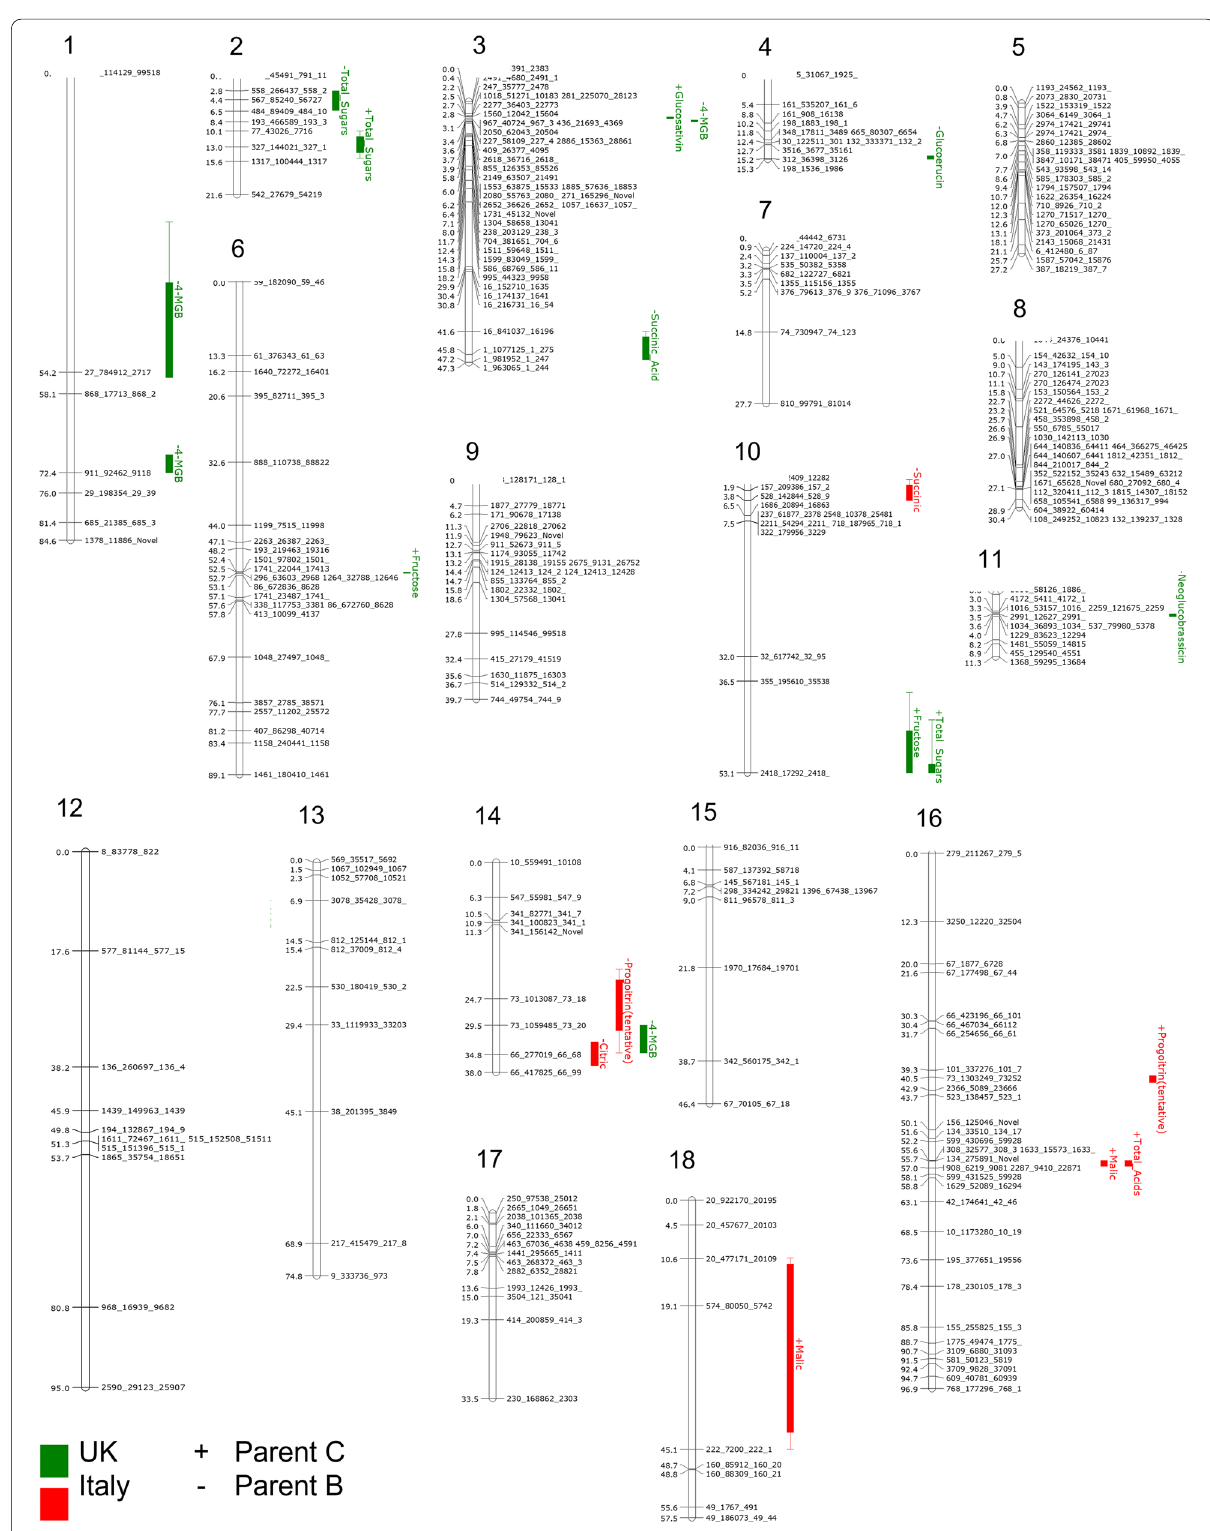
Fig. 6 QTL map showing marker distances on all Eruca vesicaria subsp. sativa linkage groups, as well as the location of QTLs identified from field trials in the UK and Italy (see inset).